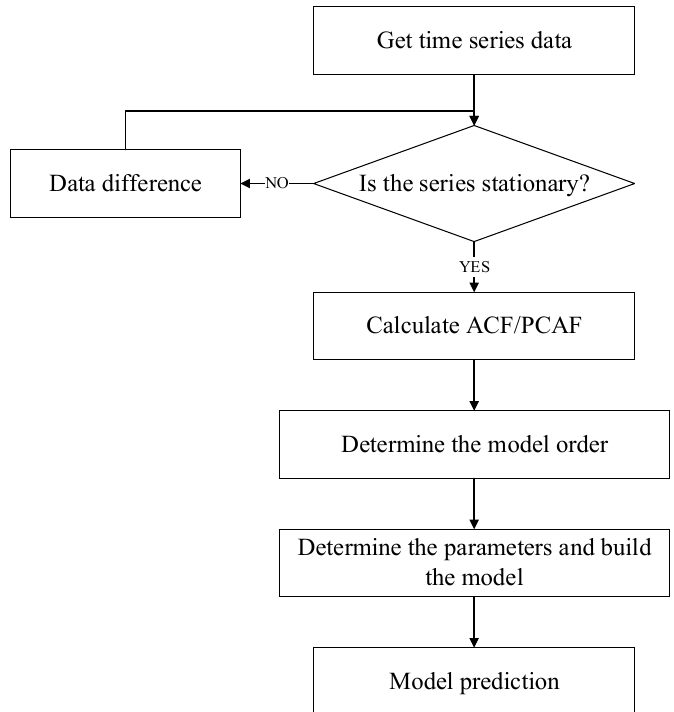
Figure 3. Program flow diagram of the model.